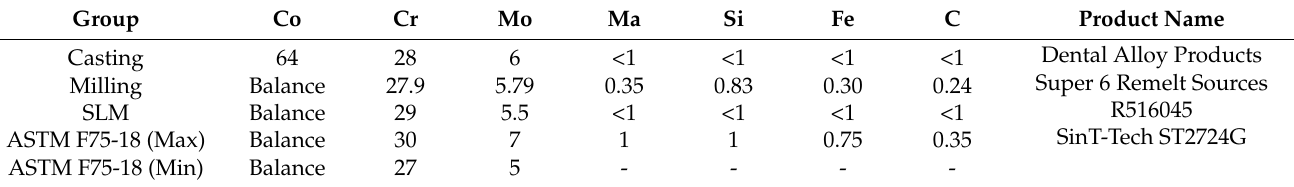
Table 4. Chemical compositions of Co-Cr dental